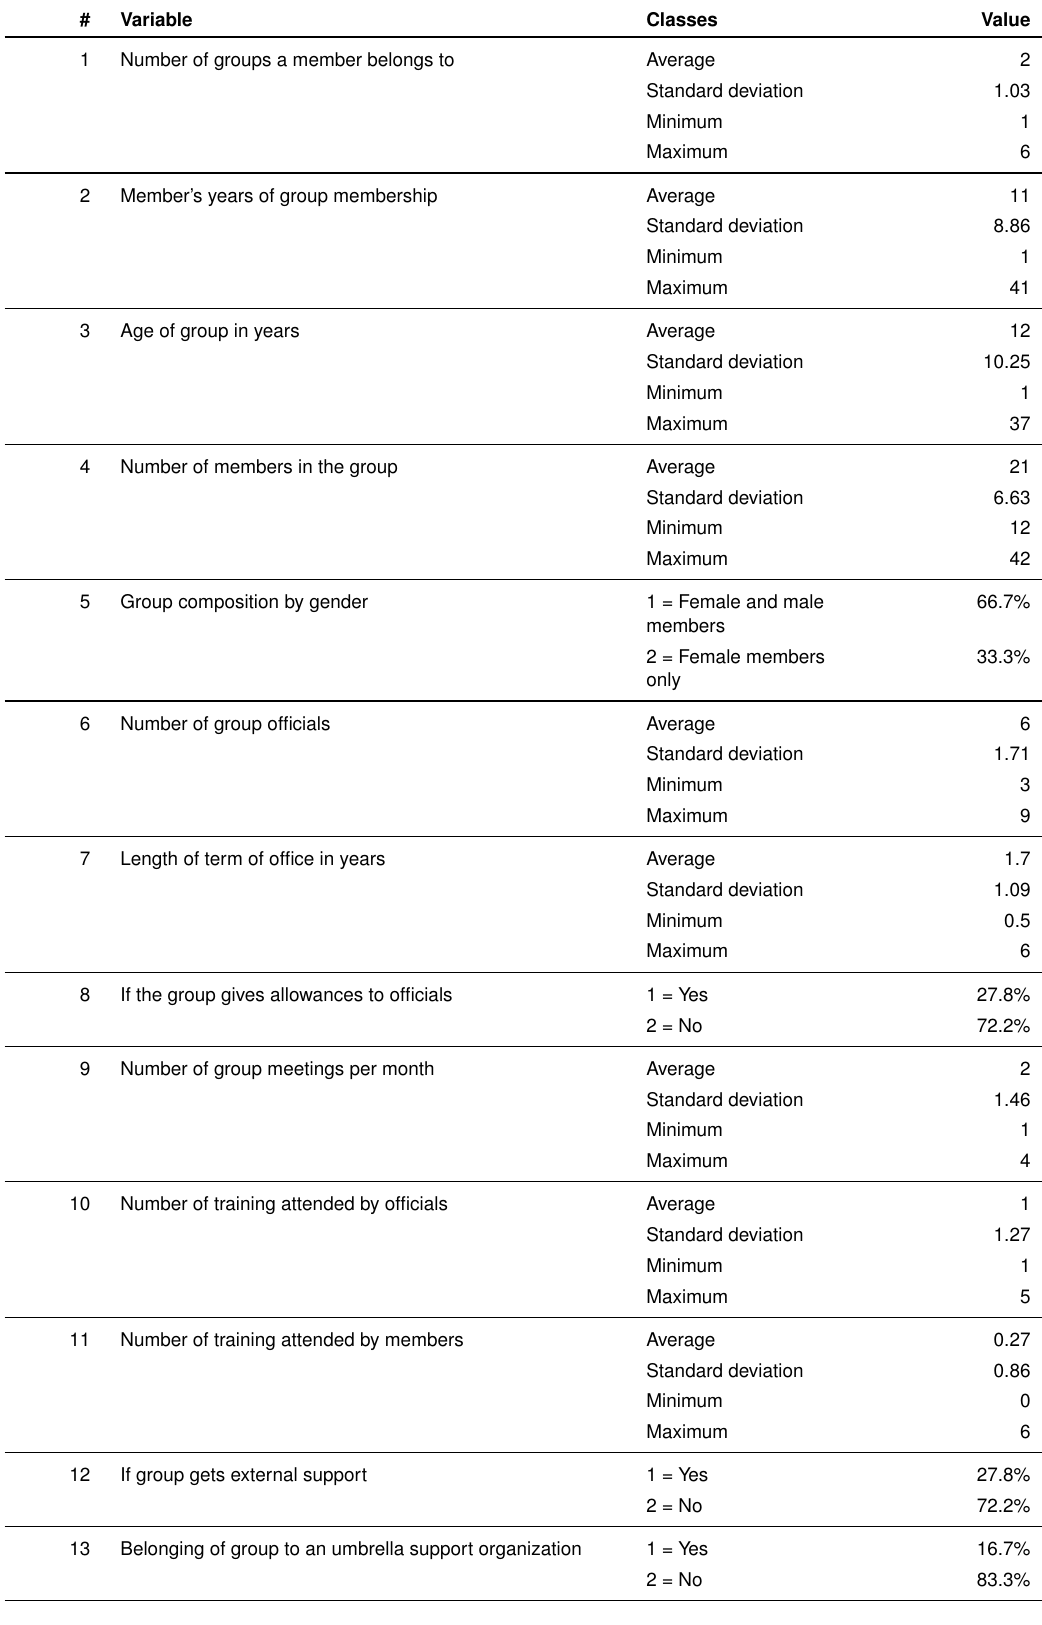
Table 8. Characteristics of the informal microfinance